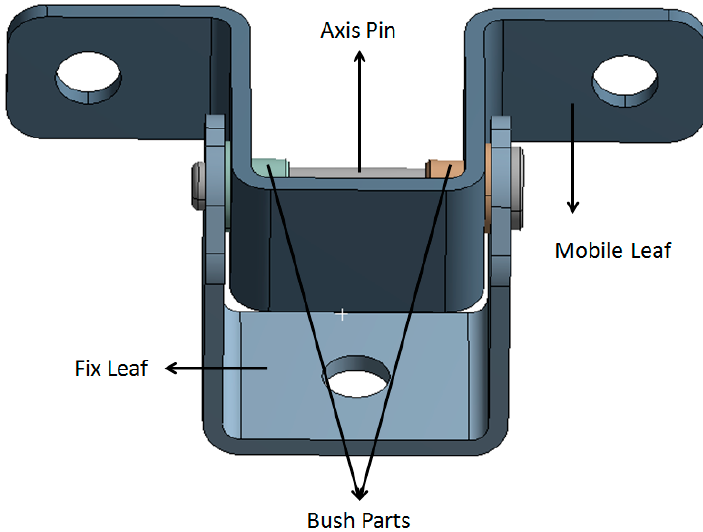
Figure 1. Commercial door hinge.